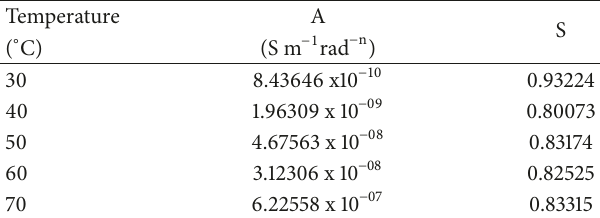
Table 2: Jonscher’s law parameters with temperature.